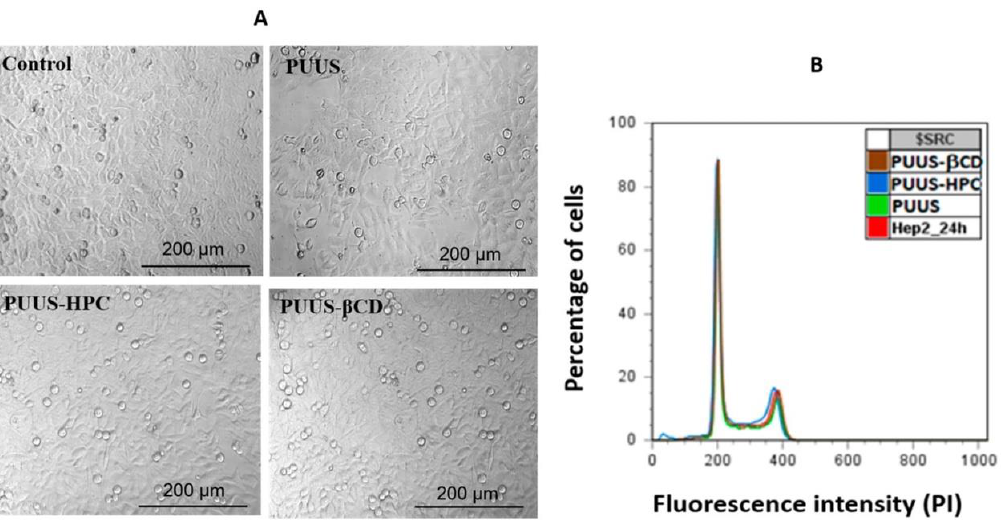
Figure 5. Cell morphology of HEp2 cells on a nanofibrous mat (PUUS) and nanofibrous composite mats (PUUS-HPC and PUUS- β CD) ( A ), cell cycle flow cytometry histograms ( B ) [89]. HPC-containing electrospun mats demonstrate both essential viabilities of the cells determined by the intensity measurements of DNA-stained HEp2 line, and improved me- chanical properties resulting in tensile stress values up to 4.8 MPa.